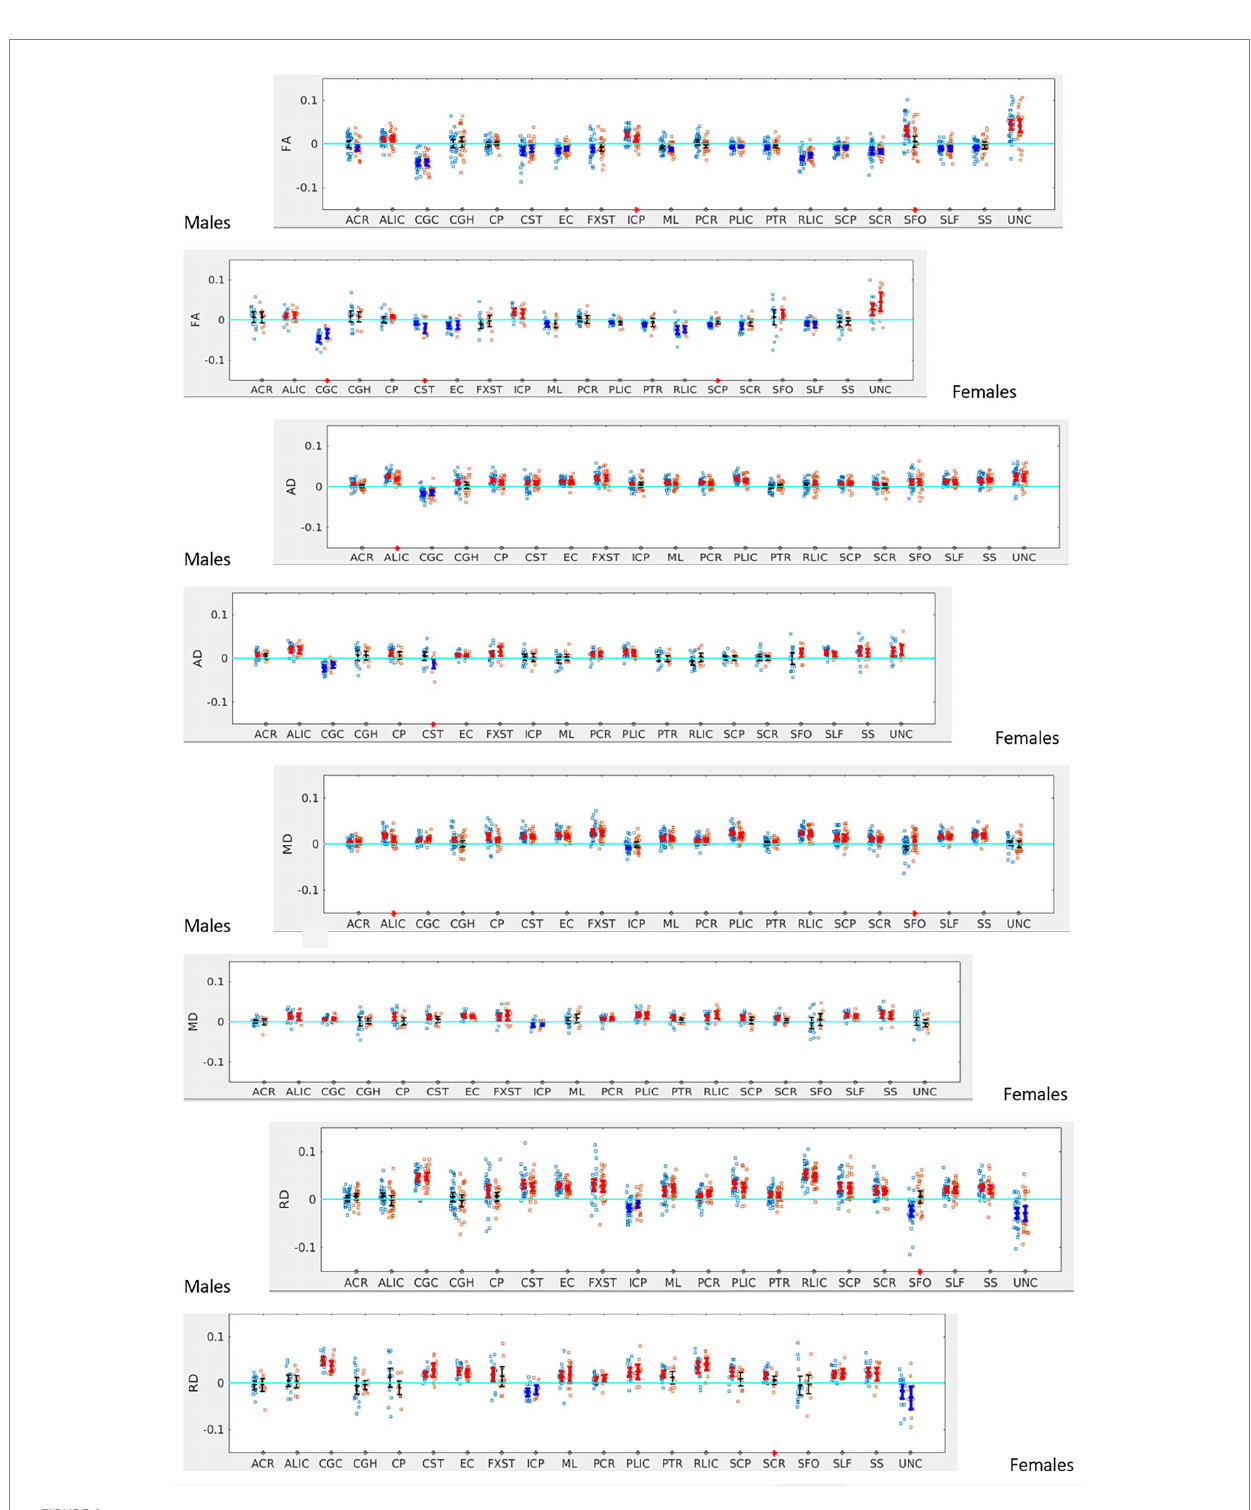
FIGURE 4 LI plotted for boys ( n = 58) and girls ( n = 29) separately for the 20 bilateral tracts for DTI metrics comparing SOR (blue dots) to non-SOR (red dots) means with 95% CI are resented in the figure for SOR and Non SOR, 95% CI bars in red represents significant right lateralization (positive LI) of the tract while blue bar represents significant left lateralizatin (negative LI) of the tract. Red asterisks on the X axis represent tracts for which difference between SOR vs. non SOR was significant at p <